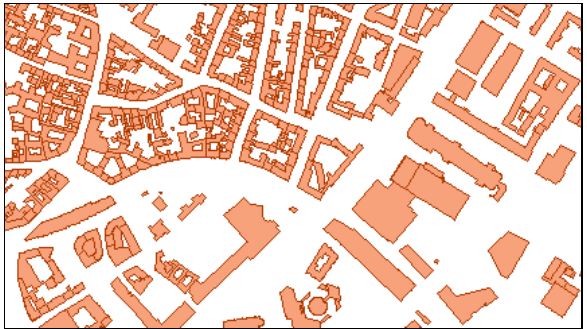
Figure 1. Example of building polygons (BKG